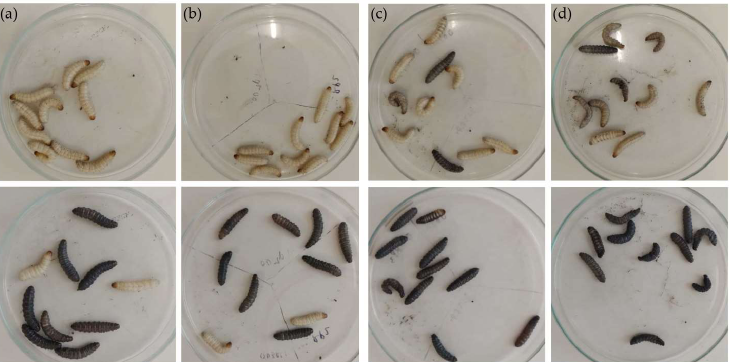
Figure 3. Omphisa fuscidentalis larvae after being injected by E. fergusonii TB1 suspension in 10 4 –10 7 CFU/larvae. The upper figure is 4 h after injection, and the lower figure is 24 h after injection. ( a ) 10 4 , ( b ) 10 5 , ( c ) 10 6 , ( d ) 10 7